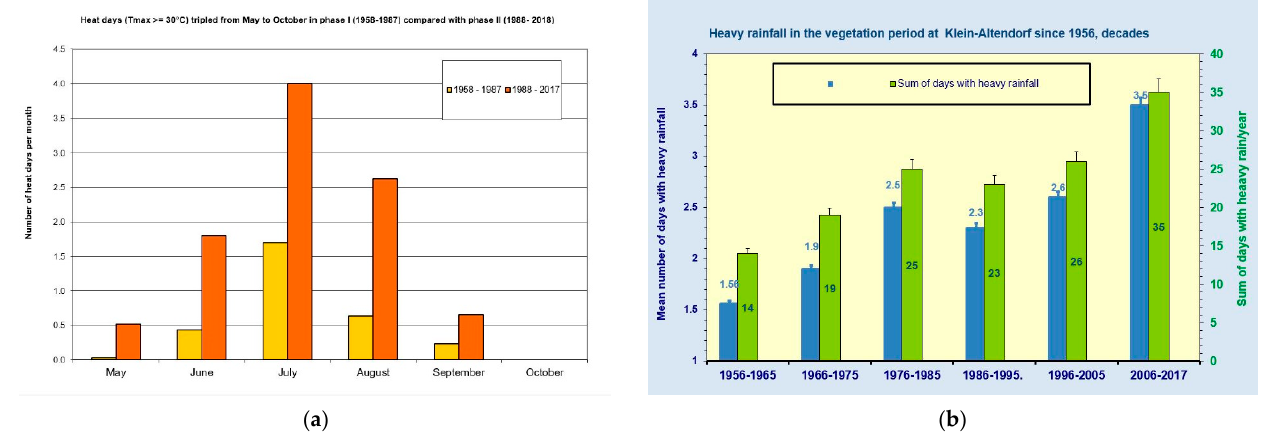
Figure 3. Increase in ( a ) heat days (Tmax ≥ 30°C) and ( b ) days with heavy rain (>20 mm/day)—mean monthly breakdown; comparison phase I (1958–1987) with phase II (1988–2017).